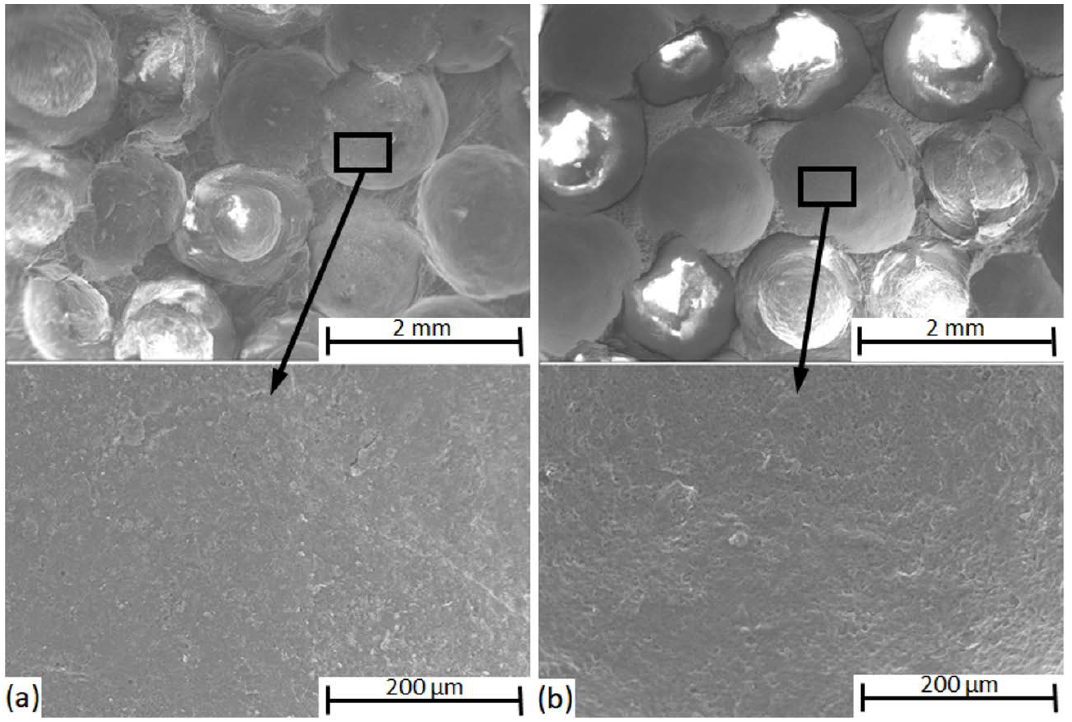
Figure 4. SEM micrographs of craters from the hollow spheres are removed during the fracture phenomenon: ( a ) Al99.5-based and ( b ) AlSi12-based MMSFs.